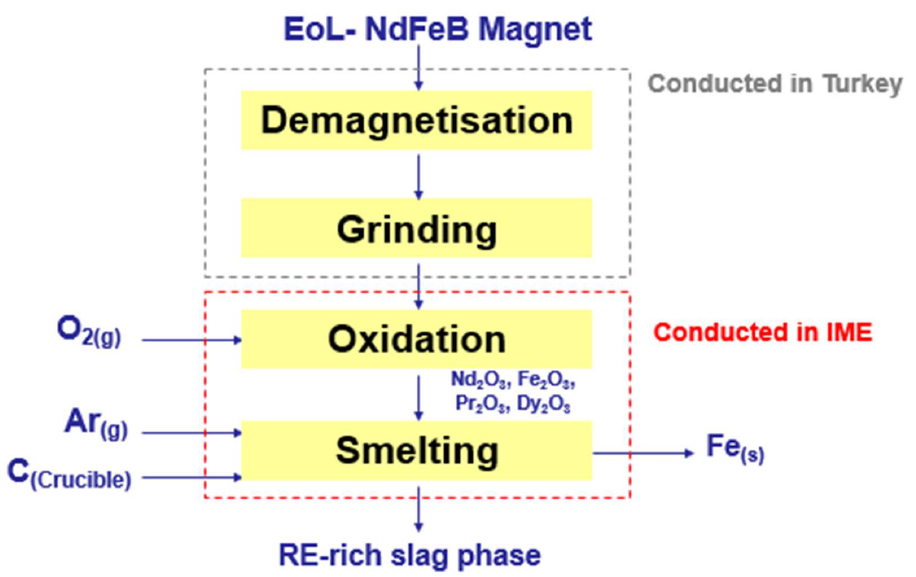
Figure 1. Proposed strategy for study in this work.